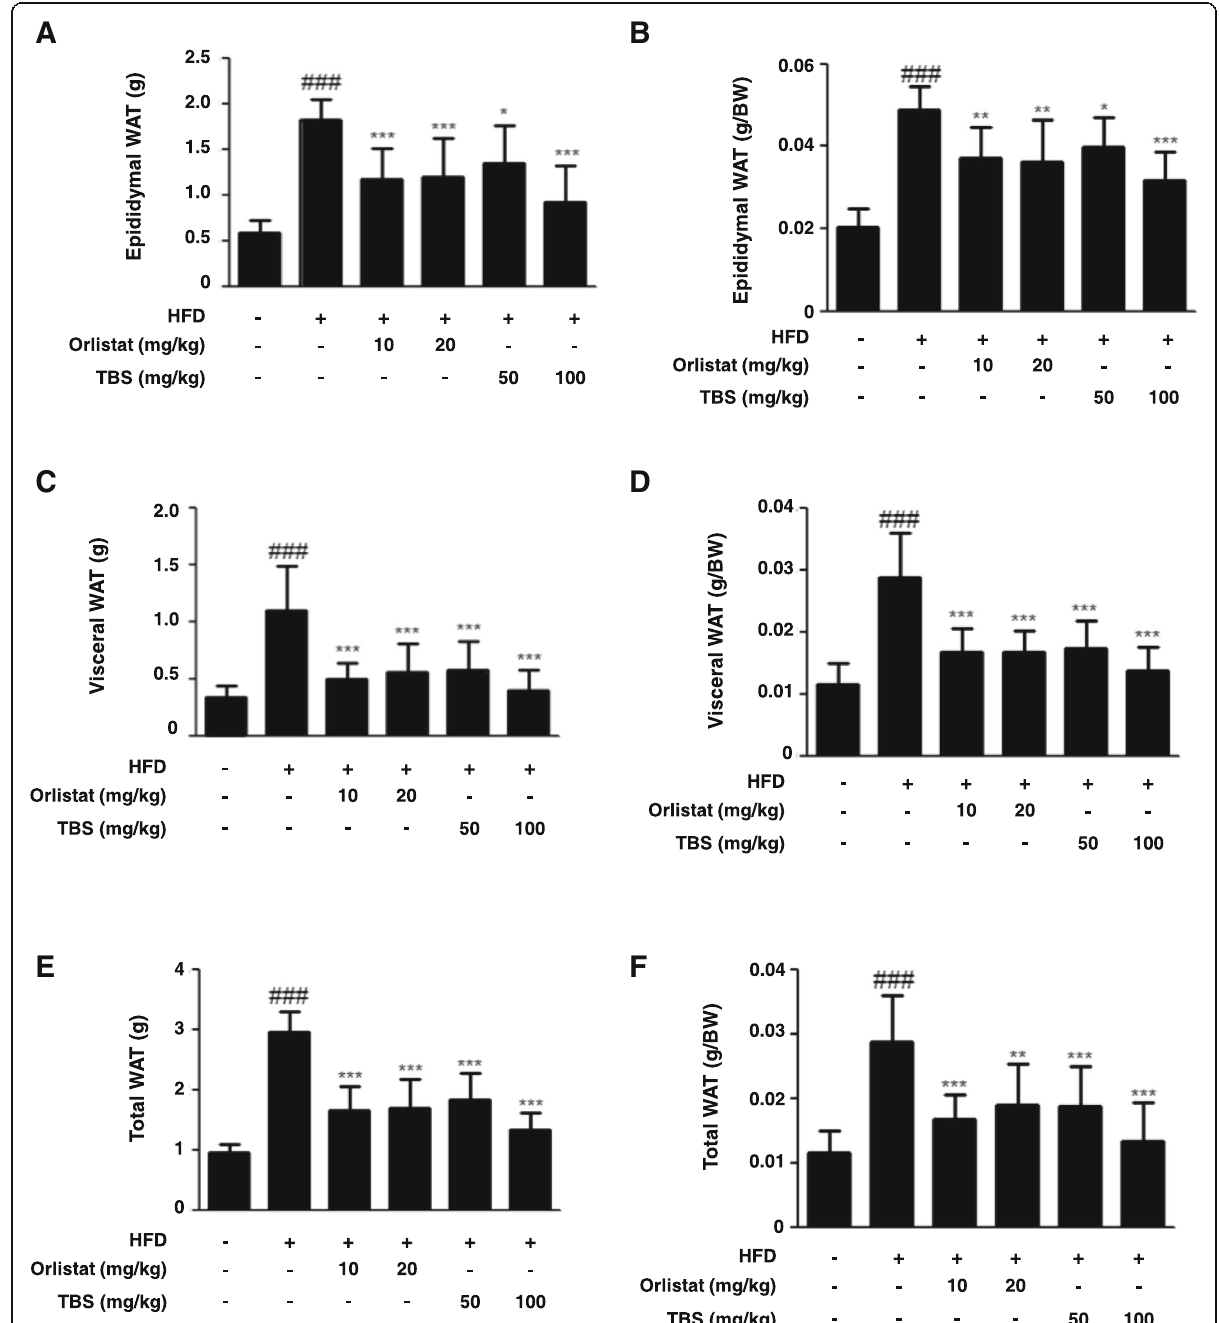
Fig. 2 Effect of TBS on adipose tissue weight in high-fat diet-induced obesity in C57BL/6N mice. ( a ) The epididymal adipose tissue weight, ( b ) relative epididymal adipose tissue weight ratio, ( c ) visceral adipose tissue weight, ( d ) relative visceral adipose tissue weight ratio, ( e ) total adipose tissue weight, and ( f ) total adipose tissue weight ratio were measured after 11 weeks of diet treatments in mice. The values represent the mean ± S.D. ### p < 0.001 vs. the control group; * p < 0.05, ** p < 0.01, and *** p < 0.001 vs. HFD